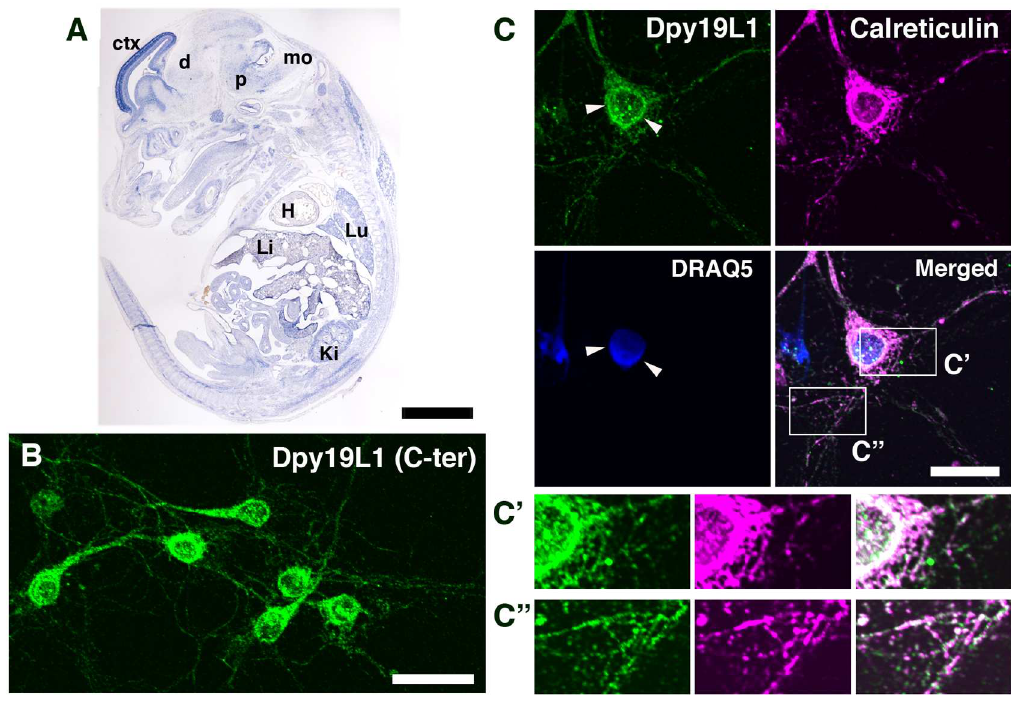
Fig 3. Dpy19L1 distribution in embryonic cortical neurons. (A) Expression of Dpy19L1 mRNA visualized by ISH on sagittal section of E14.5 mouse embryo. ctx, cerebralcortex; d, diencephalon; p, pons; mo, medullaoblongata;H, heart; Lu, lung; Li, liver; Ki; kidney. (B) Primary neuronswere preparedfrom the E14.5 mouse cerebralcortex and culturedfor 5 days. The distribution of Dpy19L1was observedby immunostaining with anti-Dpy19L1 antibody (C-ter). (C) Double immunostaining for Dpy19L1(green)and Calreticulin(magenta). Nucleus was labeledby DRAQ5 (blue). Lower right panel shows the merged image. Dpy19L1is partially colocalizedwith the ER marker Calreticulin. Arrowheads show Dpy19L1distribution aroundthe nucleus.C 0 and C @ show magnifiedimages of boxed areas. Results shown were obtained from three independent cultures. Scale bars: 200 μ m in A, 30 μ m in B, and 20 μ m in